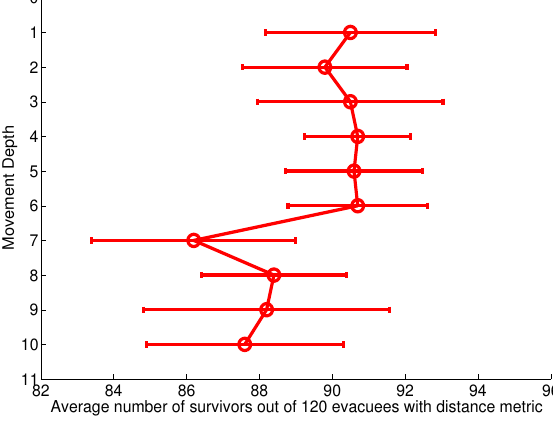
Figure 2. The average number of survivors out of 120 evacuees with different movement depths in the distance-based system. The error bars show the standard deviation